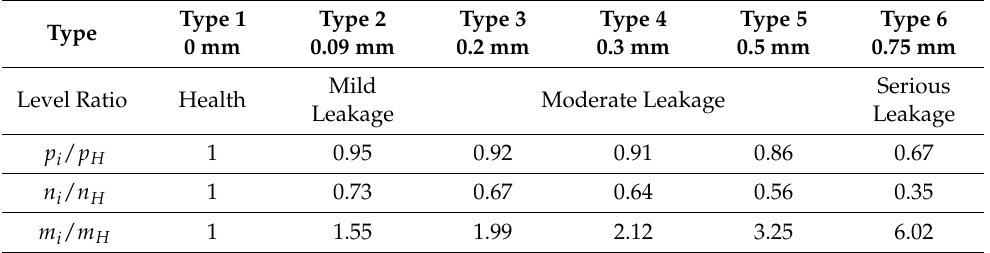
Table 2. The ratio of parameters under various leakage faults and health